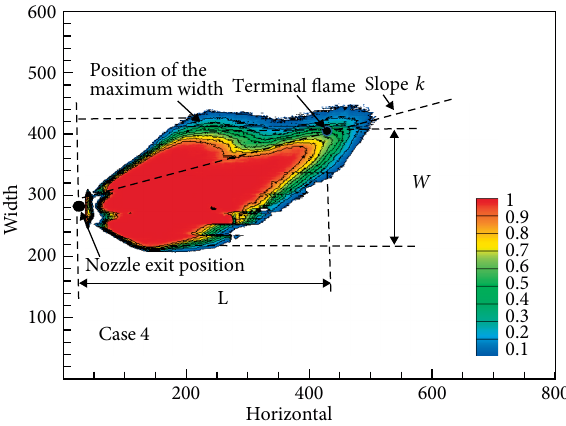
Figure 4: Flame probability characteristic parameter definition